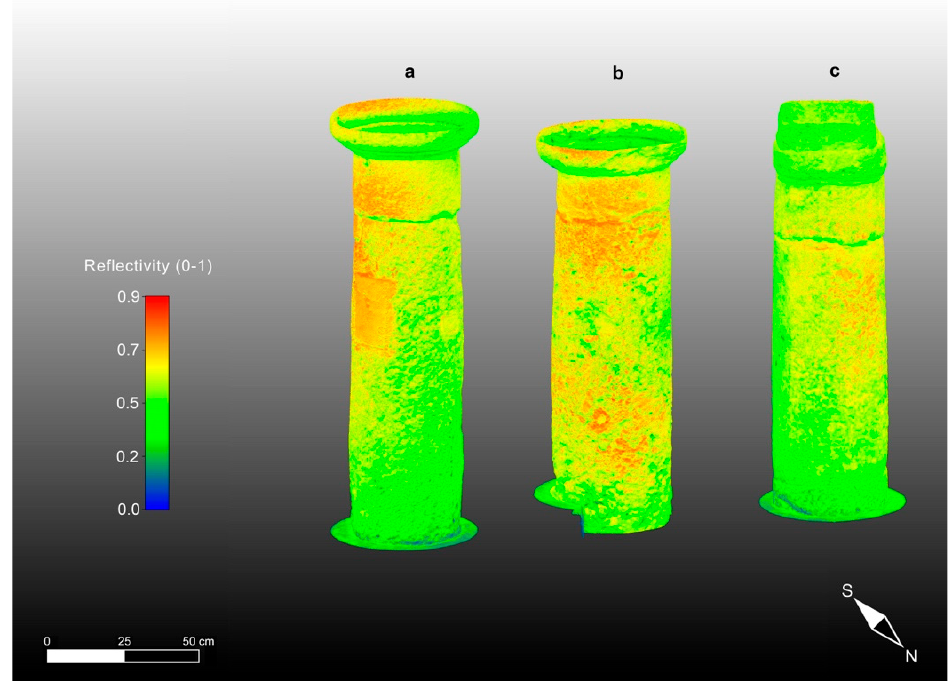
Figure 10. High-resolution 3D models of the studied columns from the Saints Lorenzo and Pancra- zio church texturized with the intensity obtained after TLS data processing: ( a ) Column 1; ( b ) Column 2; ( c ) Column 3.